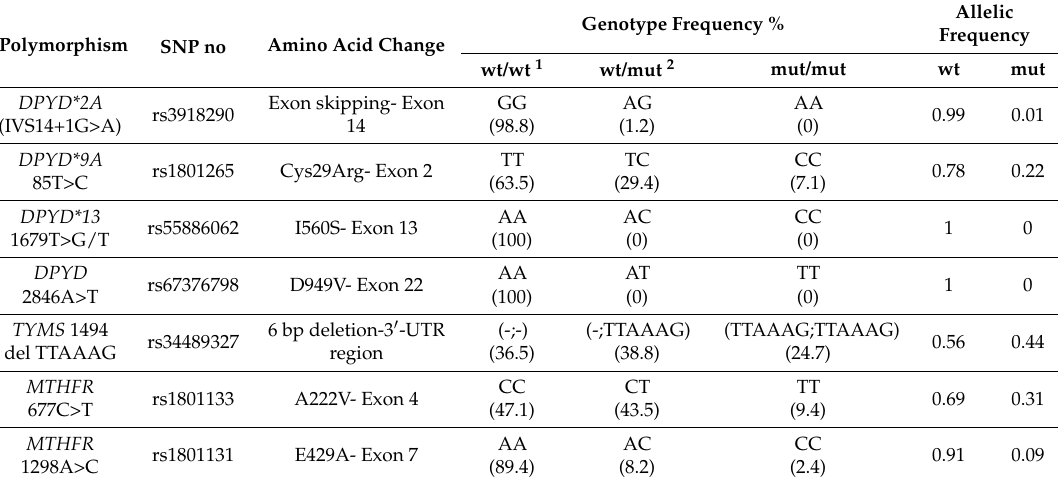
Table 3. Genotyped polymorphisms and allelic frequencies of detected polymorphisms among all patients.